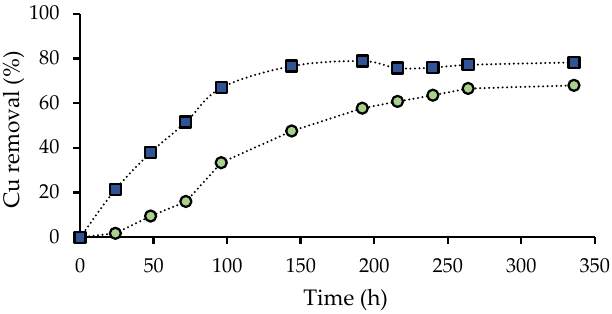
Figure 3. Cu removal efficiency during the bioleaching experiments for the PCB powder sample (blue square) and the PCB piece without epoxy layer (green circle).